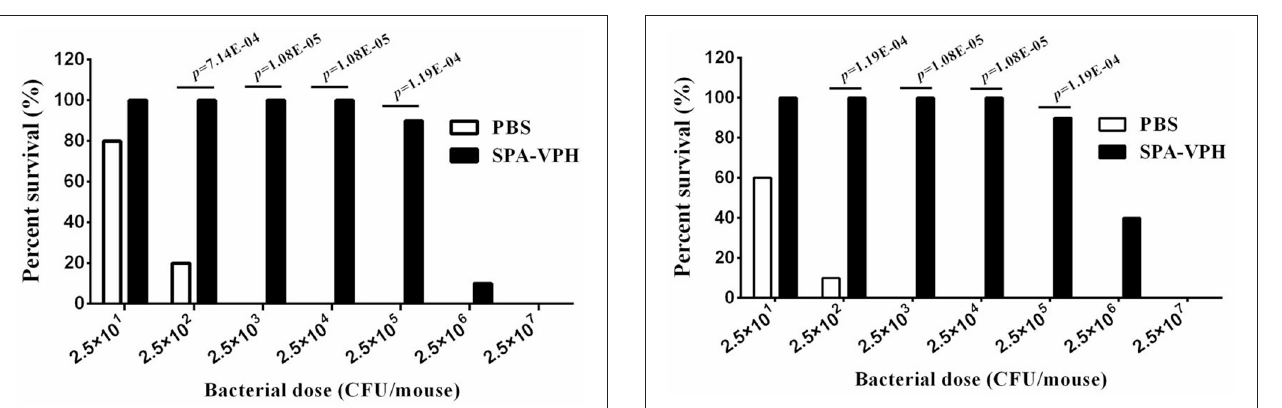
FIGURE 6 | Immunoprotection by nasal vaccination with SPA-VPH in BALB/c mice against challenge of Salmonella enterica serovar Paratyphi A wild-type. BALB/c mice were nasally administered with SPA-VPH at 2.0 × 10 9 CFU/mouse, or PBS as control. On the 30 day postvaccination, immunized mice were intraperitoneally challenged with 10-fold diluted bacterial suspensions of S . Paratyphi A wild-type from 2.5 × 10 1 to 2.5 × 10 7 CFU suspended in 10% gastric mucin. PBS-immunized mice were challenged at doses from 2.5 × 10 1 to 2.5 × 10 4 CFU per mouse. After challenges, deaths of mice were monitored within 72 h. Survival percent of PBS-immunized mice at challenging doses from 2.5 × 10 5 to 2.5 × 10 7 are regarded as zero.